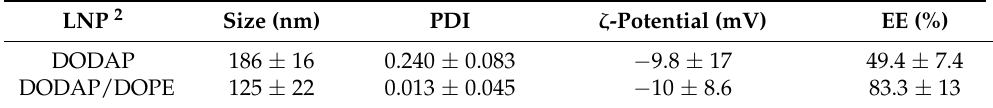
Table 1. Characterization of DODAP-LNPs prepared with or without DOPE 1 .